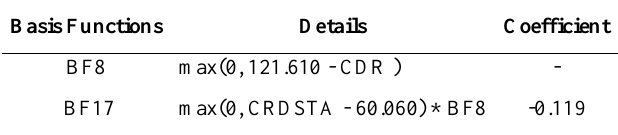
Table 11: Basis Functions of